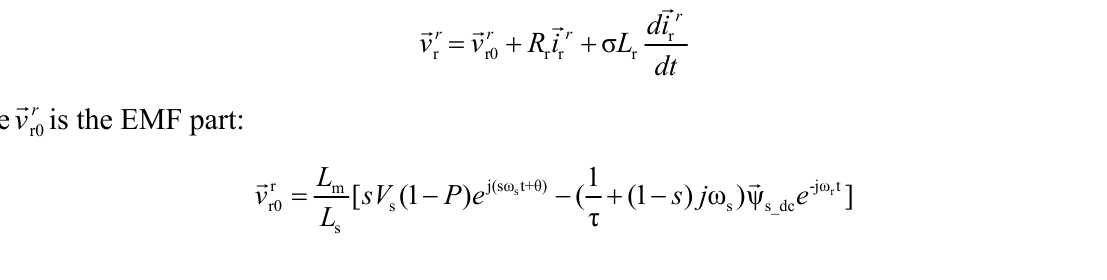
Figure 4. Simulation results for three-phase faults (0.5 p.u.) with different voltage phase when faults occur and phase-angel jumps ( a ) phase angel jump θ = 0°, ω t = k π ; ( b ) phase angel jump θ = 0°, ω t = ( k + 0.25) π ; and ( c ) phase angel jump θ = 60°, ω t = k π